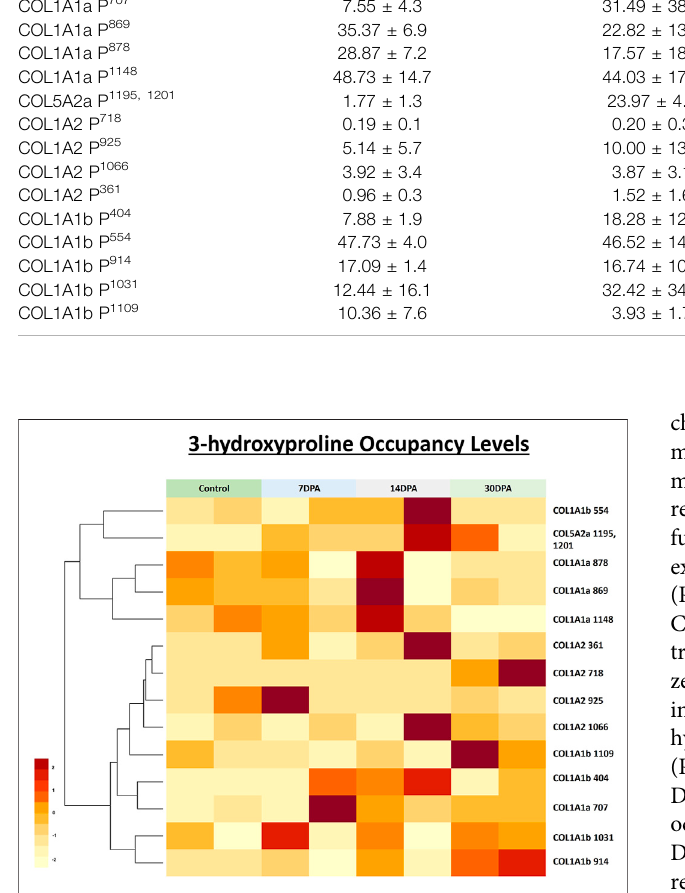
FIGURE 7 | Heatmap depicting the relative occupancy level of 3- hydroxyproline sites in three different chains of collagen 1 deposited in zebra fi sh heart ECM during regeneration. Further occupancy of one 3-HyP clusterofCOL5A2a 1195,1201 wasalsoquantitatedduringzebra fi shheart regeneration. Normalized occupancy values of prolyl-3-hydroxylations were computed to generate the heat map. Light yellow represents the low value (lowest occupancy) and dark red shows the higher value (highest occupancy) in the